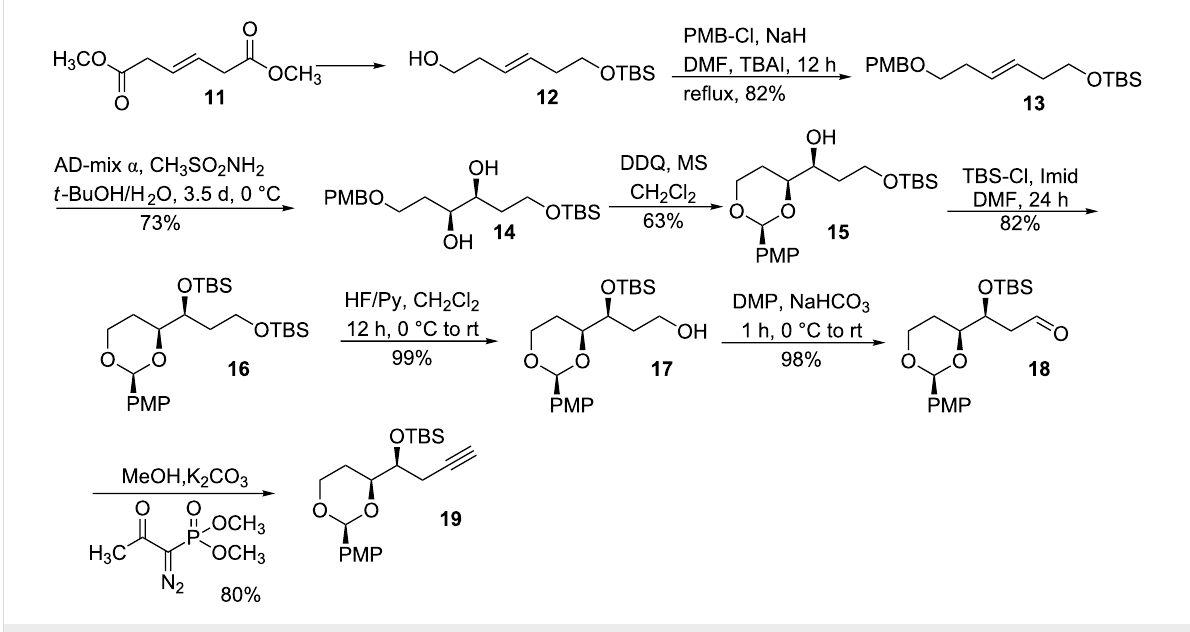
Scheme 4: Synthesis of homopropargyl silyl ether.